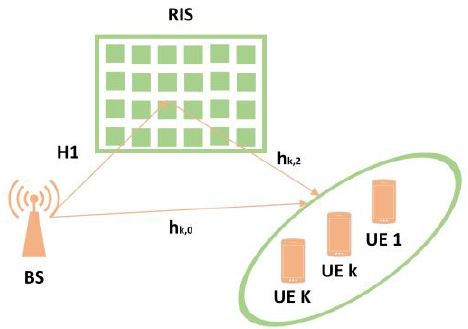
Figure 1. Illustration of the RIS-assisted MU-MISO communication system.